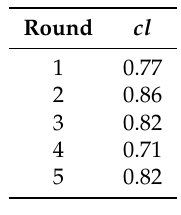
Figure 8. CRP evolution with [55]. Table 2. Consensus level in different